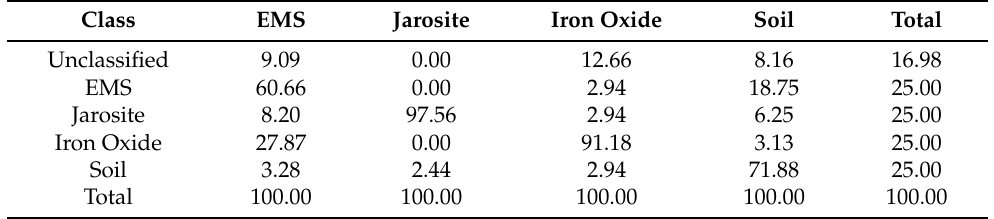
Table A7. July 2019 maximum likelihood. Overall accuracy points: 154/200, overall accuracy: 77%, kappa coefficient: